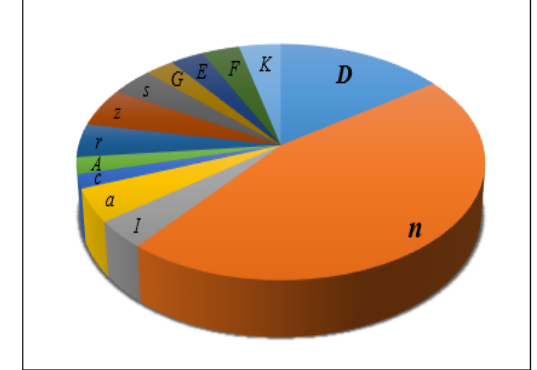
Fig. 2. Chromosome structure of the cuckoo algorithm.